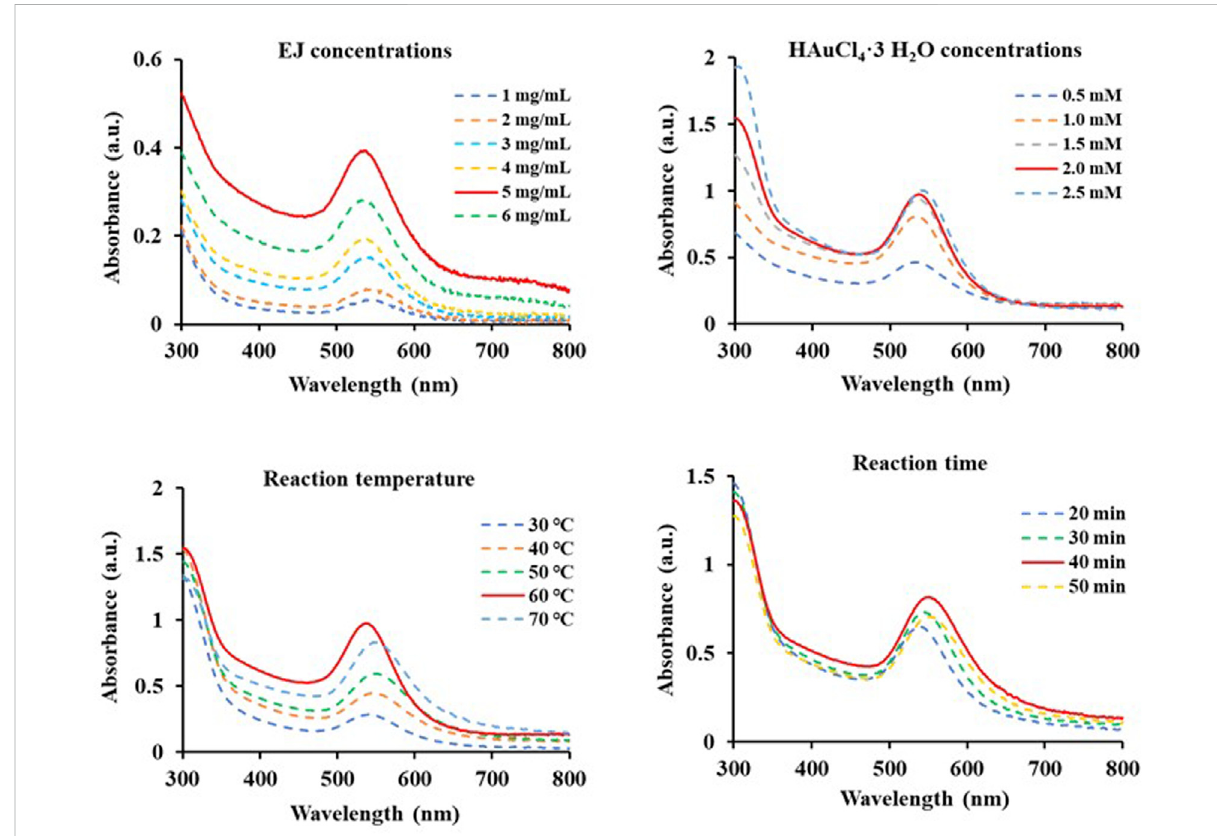
Scanning spectra at absorbances of 300 – 800 nm of diverse EJ-based gold nanoparticles (EJ-AuNPs) synthesized under various conditions (cid:129) depending on EJ concentrations (1 – 6 mg/ml), HAuCl 4 3H 2 O concentrations (0.5 – 2.5 mM), reaction temperatures (30 ° C – 70 ° C), and time (20 – 50 min). The red solid line in each Figure indicates the optimal